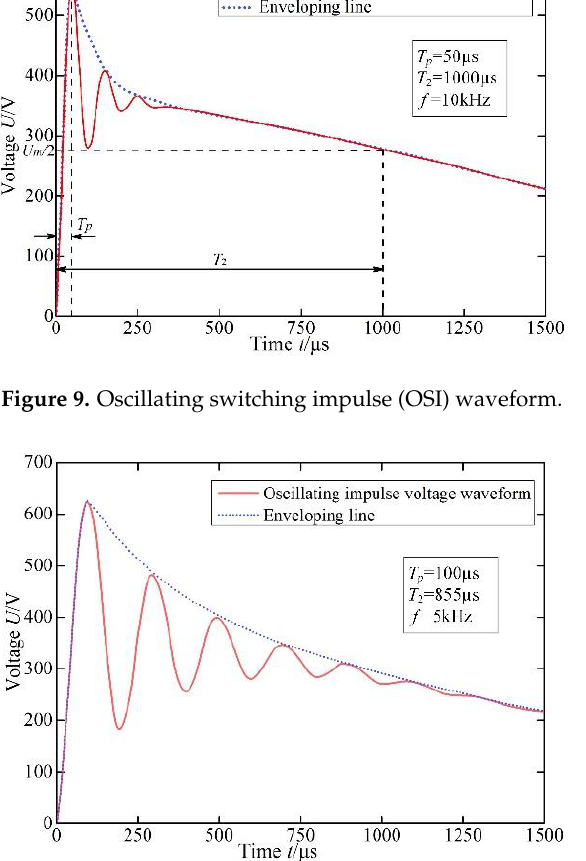
Figure 10. OSI waveform after changing L .